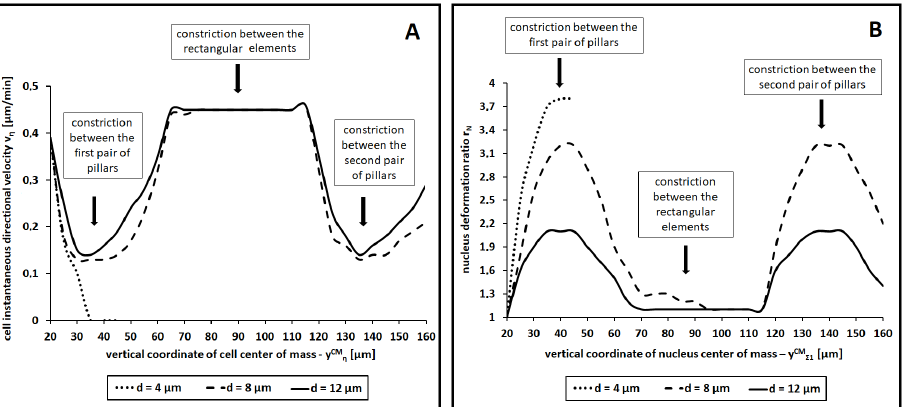
Figure 4. Quantification of cell migratory behavior in the experimental design employed in [19]. Time evolution of cell instantaneous directional velocity v η ( panel (A) ) and of nucleus deformation ratio r N ( panel (B) ) for three representative values of the distance d between the pairs of round pillars. In both graphs, each value is the mean over 10 simulations. We have not plotted error bars, to avoid unnecessary graphical overcomplication. However, the standard deviations were very small (of the order of 10 − 2 ). We also remark that, in the simulation settings employed in this part, the initial nuclear diameter was d N = 14 µ